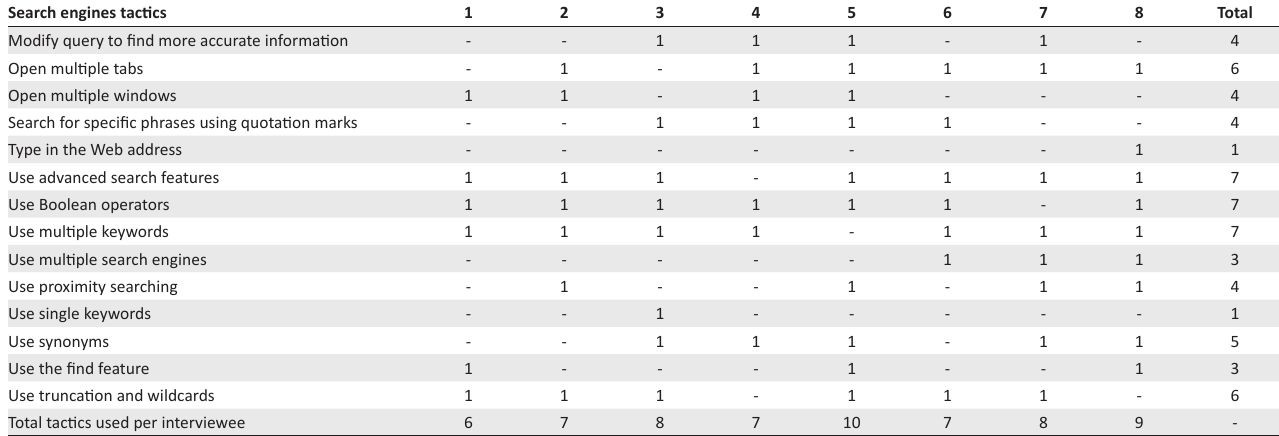
TABLE 2: Web search strategies using search engines. Search engines